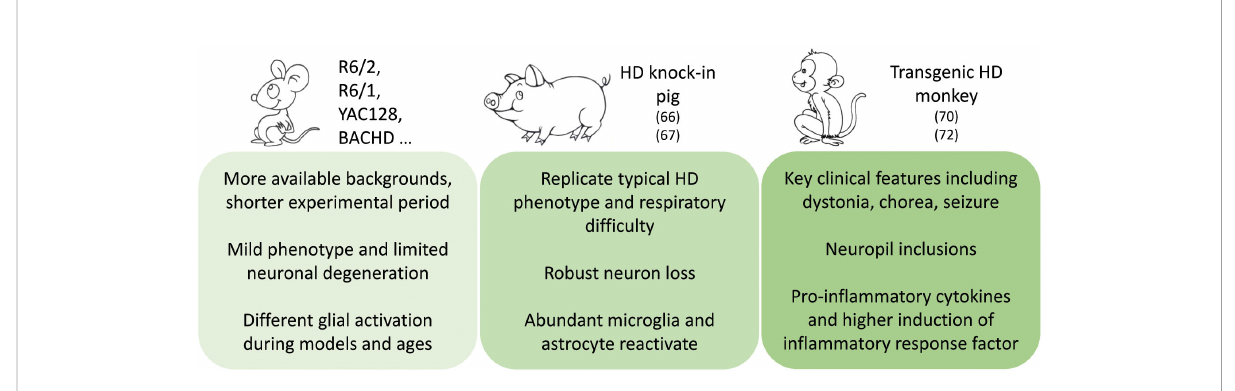
FIGURE 1 Pathogenic insights from and phenotype differences between animal models expressing mutant